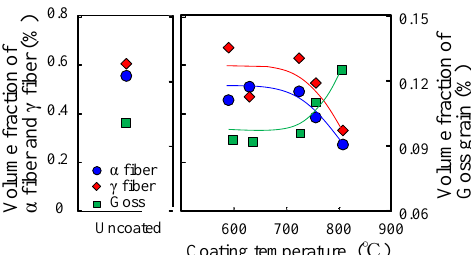
Figure 3. Effect of coating temperature on volume fractions of α fiber, γ fiber, and